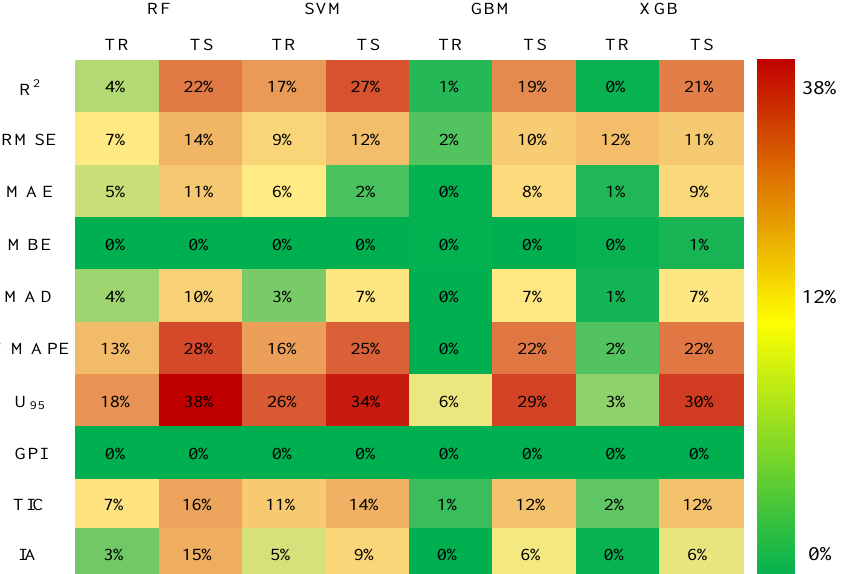
Figure 12. Error matrix for training and testing dataset.